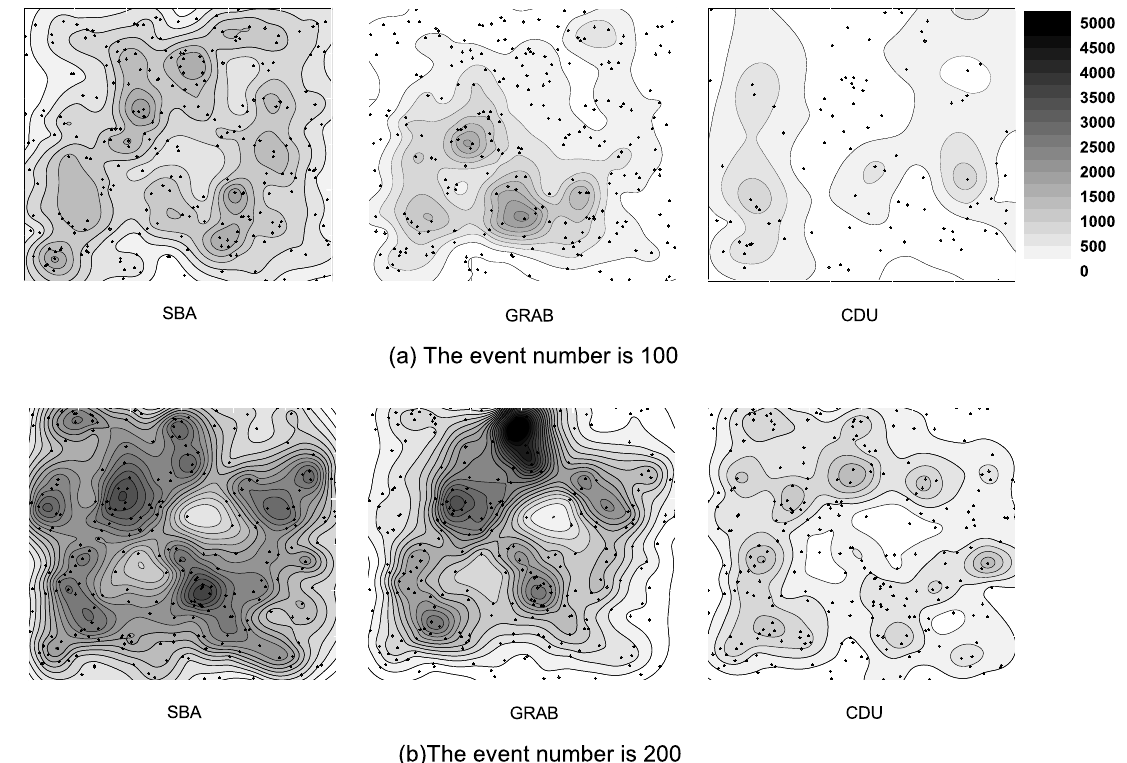
Figure 8. Energy consumption distribution(mJ) for different scenarios. ( a ) introduces the comparisons of the energy distribution after relaying data with 100 events; ( b ) introduces the comparisons of the energy distribution after relaying data with 200